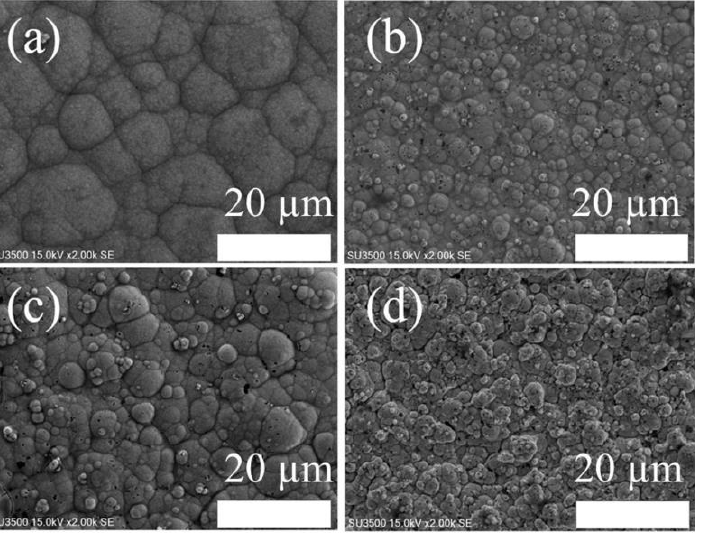
Figure 1. SEM images of ( a ) Ni-W alloy and Ni-W/B nanocomposite coatings with varying boron concentrations: ( b ) 0.5 ( c ) 1, and ( d ) 3 g/L after electroplating.